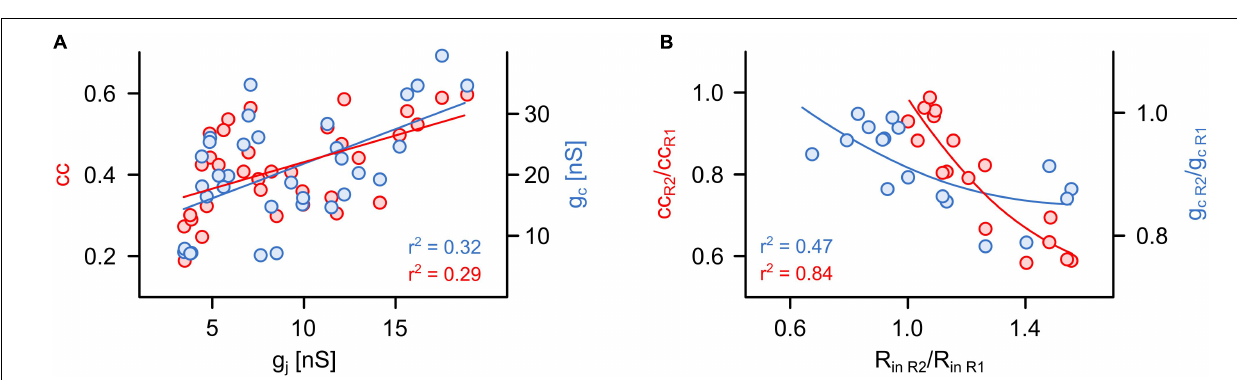
FIGURE 3 | The coupling coefficient and the coupling conductance are strongly influenced by non-junctional factors. (A) Relationship between cc or g c and simultaneously obtained actual value of g j ( n = 34 cells from 17 pairs). (B) Relationship between the apparent asymmetry of electrical coupling (cc or g c ratios shown in Figure 2 ) and differences in input resistances (R in ratio) of both R cells in each pair ( n = 17